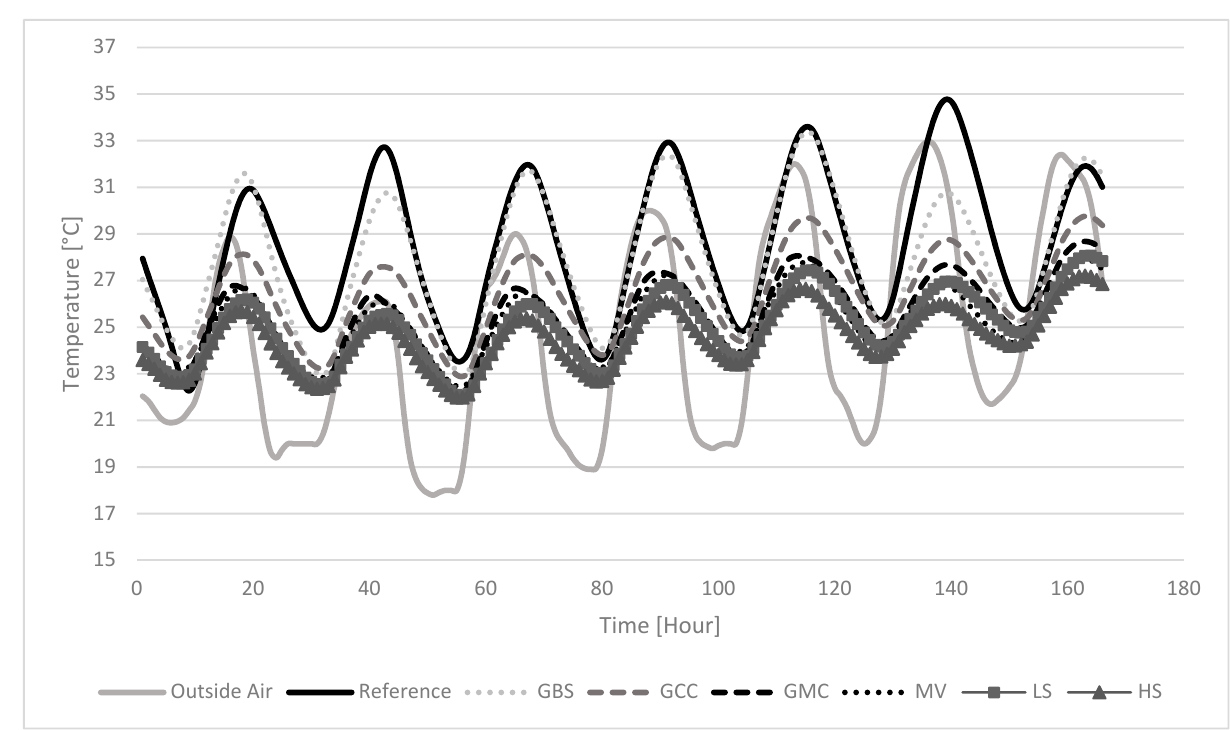
Figure 6. Summer. Comparison between the operative temperatures obtained for each category and outside air.